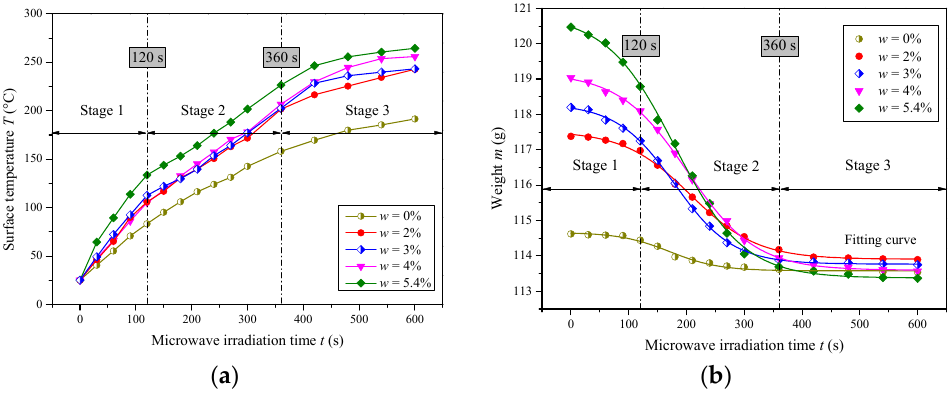
Figure 9. Surface temperature ( a ) and weight ( b ) of sandstone vs. microwave irradiation time.